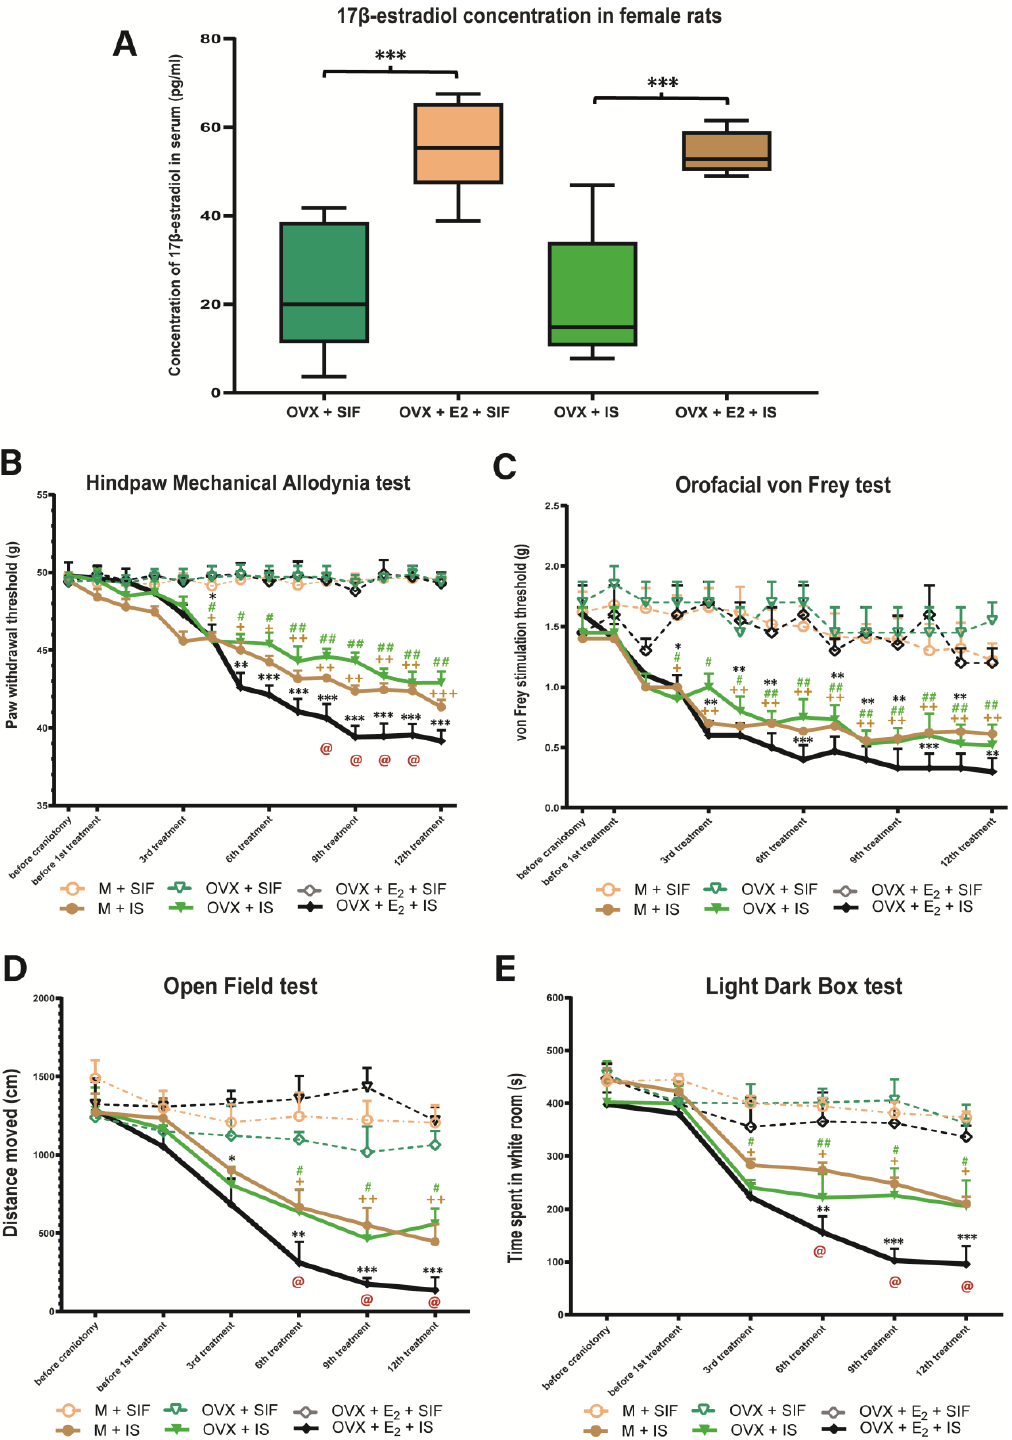
Figure 2. Statistical analysis of the serum concentration of 17-estradiol and behavior tests. ( A ) The concentration of 17β - estradiol in serum (pg/mL) in the female rats. The chronic 17β -estradiol treatment significantly increases the serum concentration compared with the cholesterol (*** p < 0.001).